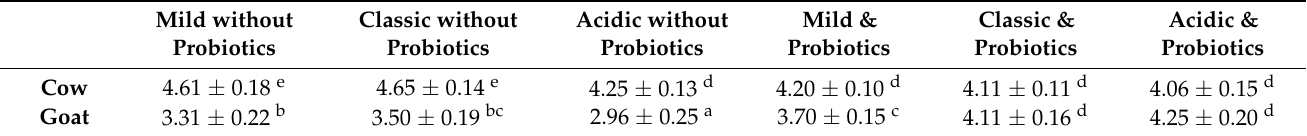
Table 5. Mean values and standard deviations of flavor of dessert yogurts (after 1 day of storage) made using different milk types, starter cultures and probiotic bacterial strains.